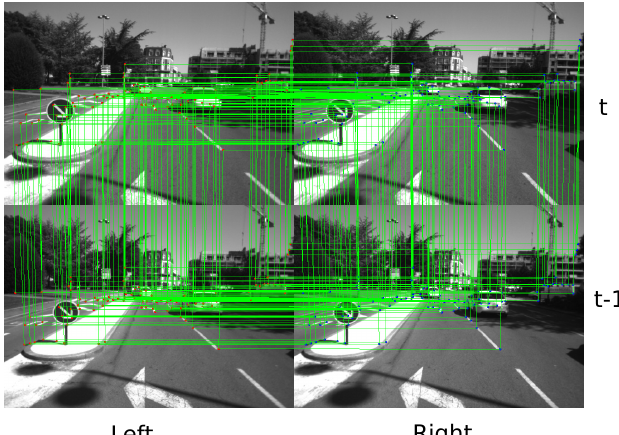
Circular feature tracking between two subsequent stereo image pairs after a refine